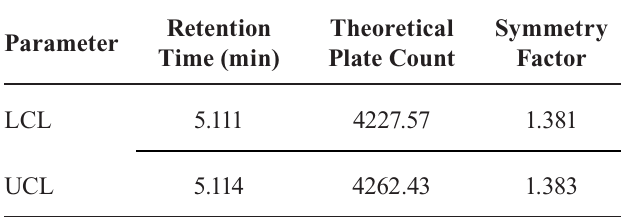
Table V - R esults of control charts obtained for CQAs